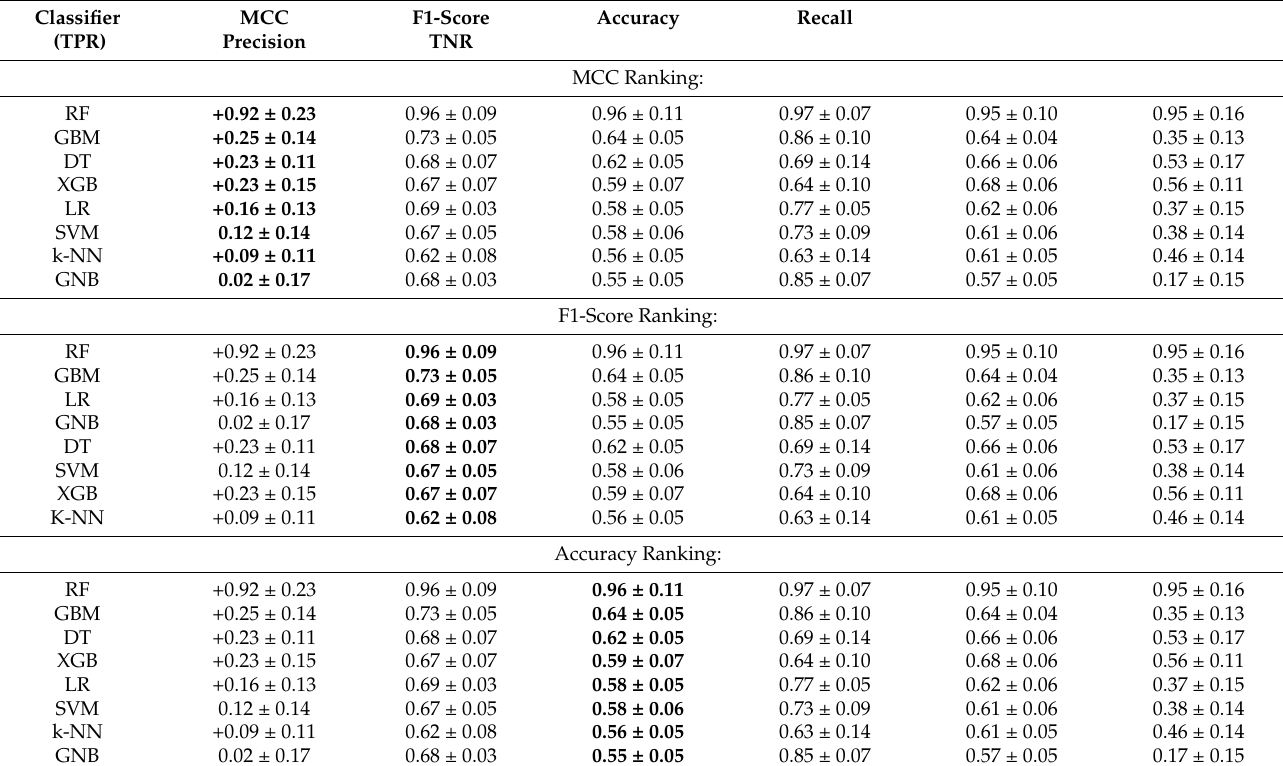
Table 15. Age Group Classification Performance